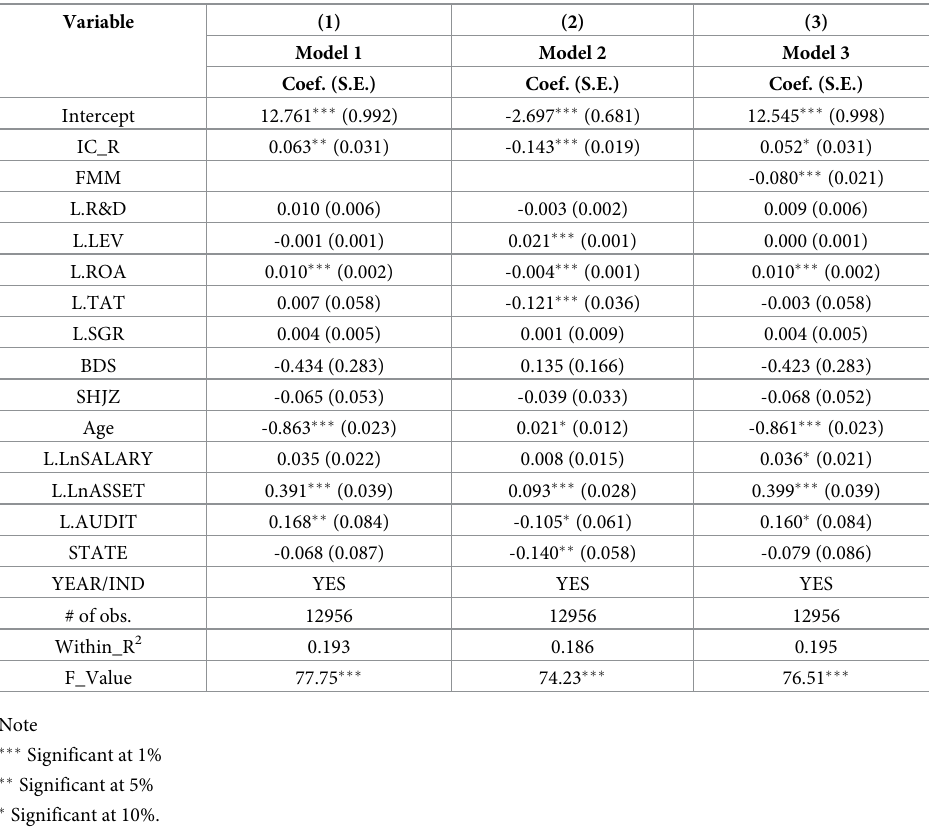
Table 8. Regression results for re-measuring IC